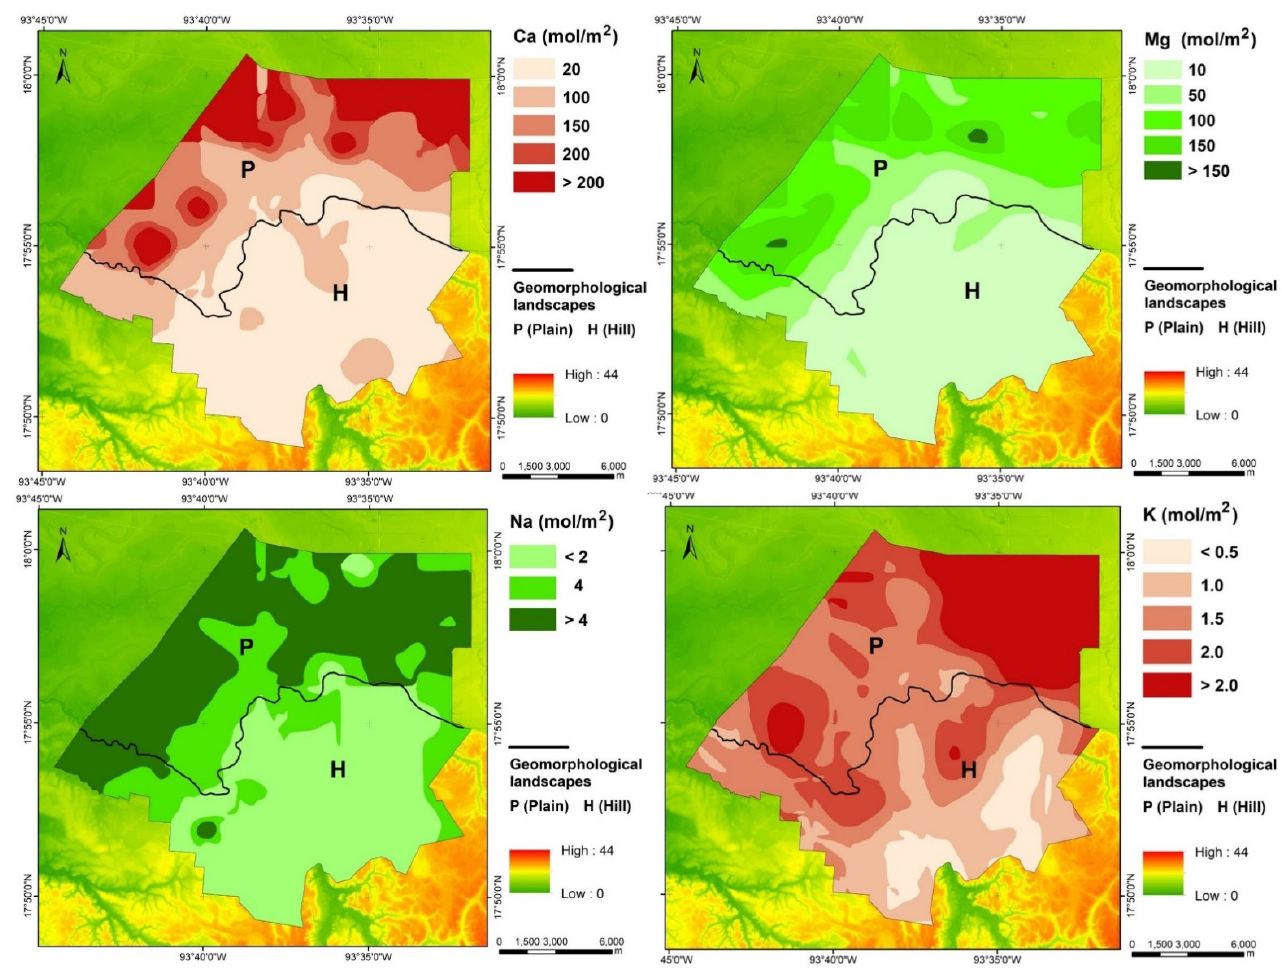
Figure 3. Spatial distribution of exchangeable cations.